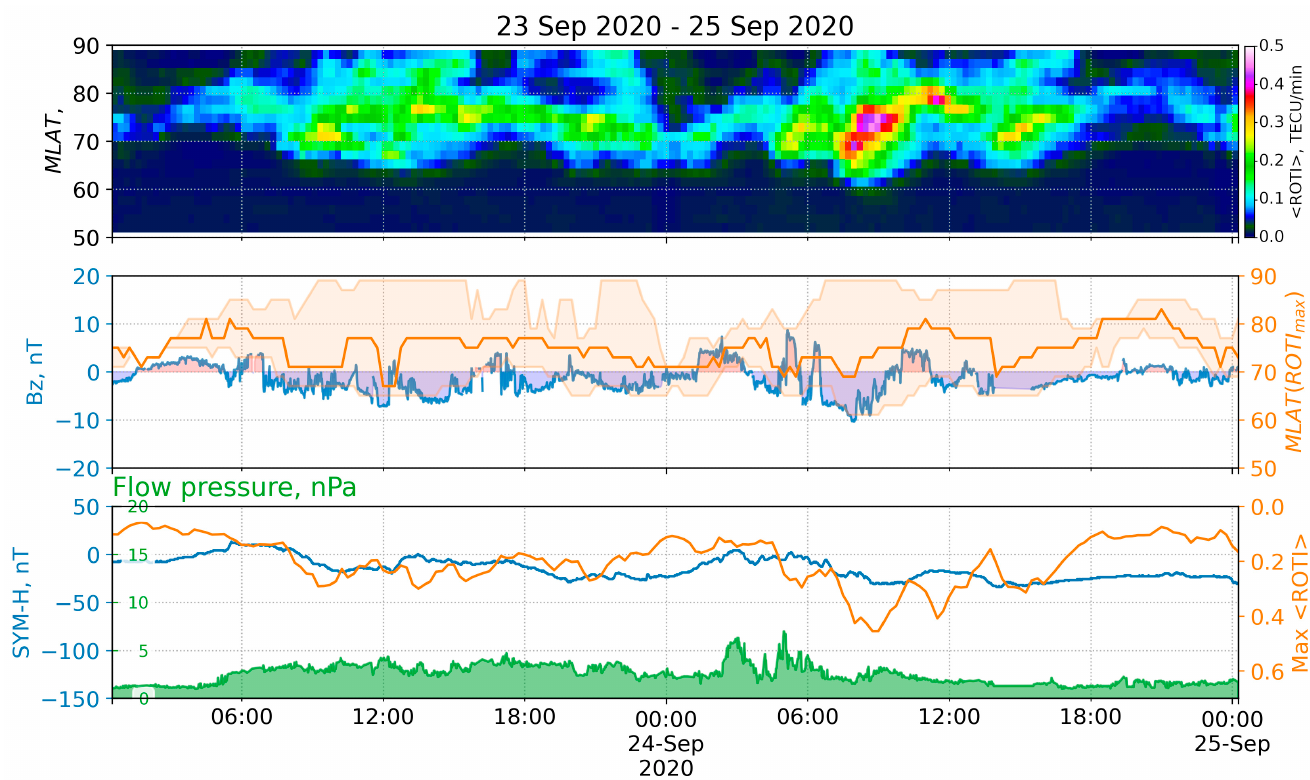
Figure 5. ROTI keogram and space weather parameters for the storm of 24 September 2020: ( top ) keogram of average ROTI (<ROTI> versus MLAT versus time); ( middle ) IMF Bz ( blue ), MLAT positions of maximum <ROTI> ( orange ), and values exceeding median ROTI at the moment ( orange filling ); ( bottom ) SYM-H index ( blue ), <ROTI> max ( orange ), and flow pressure ( green ).